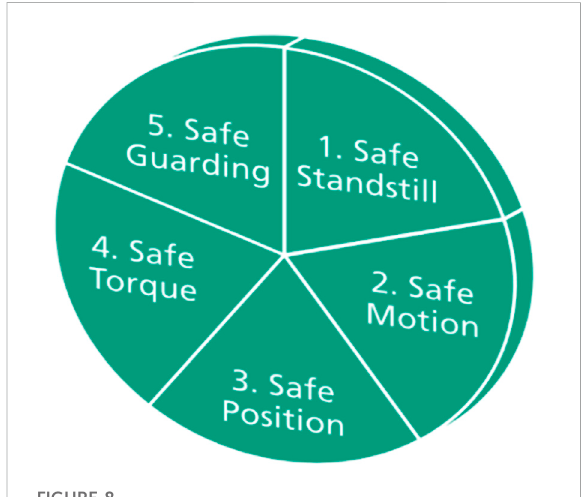
FIGURE 8 Overview of main categories of the safety functions.